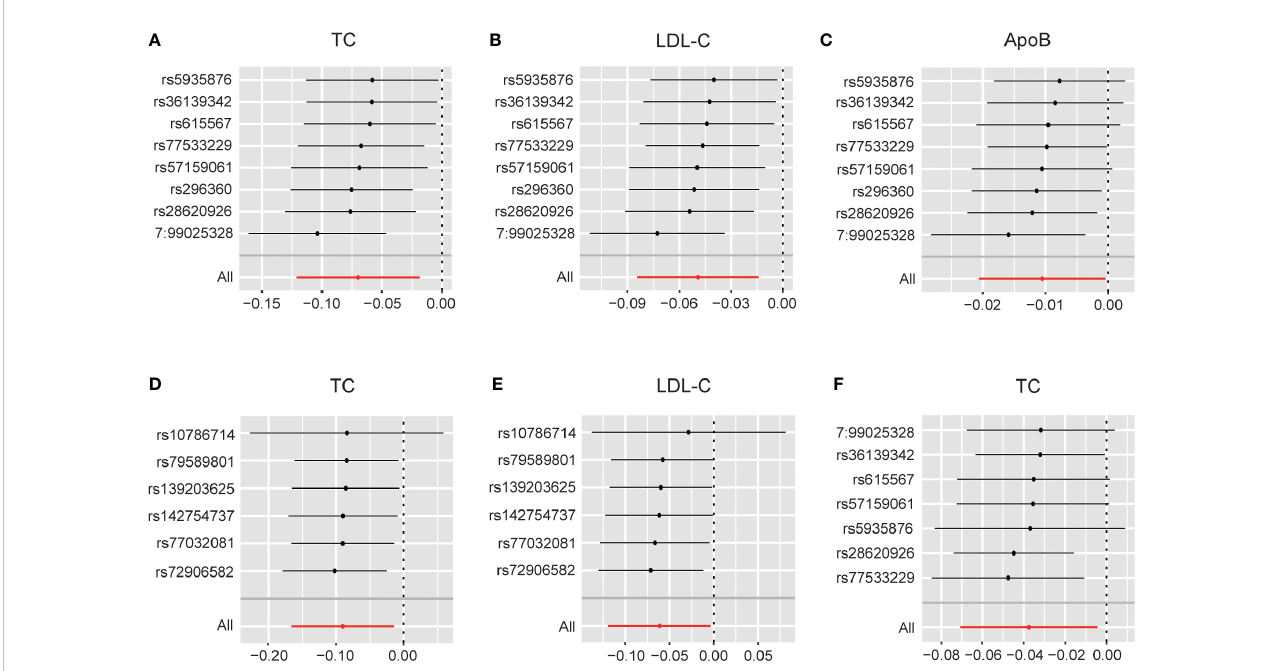
FIGURE 5 (A) Leave-one-out analysis plots for DHEAS on total cholesterol in males; (B) Leave-one-out analysis plots for DHEAS on LDL-C in males; (C) Leave-one- out analysis plots for DHEAS on apolipoprotein B in males; (D) Leave-one-out analysis plots for progesterone on total cholesterol in males; (E) Leave- one-out analysis plots for progesterone on LDL-C in males; (F) Leave-one-out analysis plots for DHEAS levels on total cholesterol in females. LDL-C, low-density lipoprotein cholesterol; TC, total cholesterol; ApoB, apolipoprotein